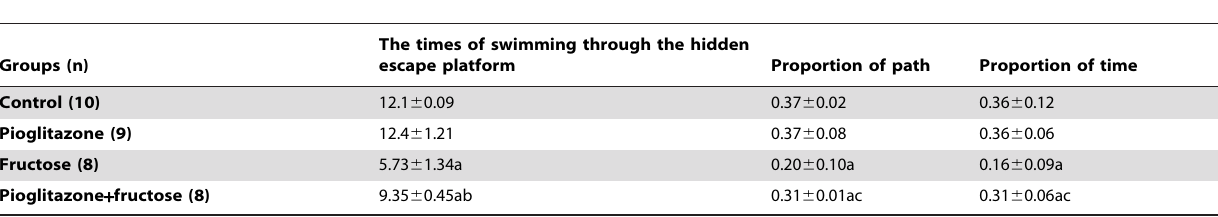
Table 2. Comparison of learning and memory ability among the groups during the probe trial test.